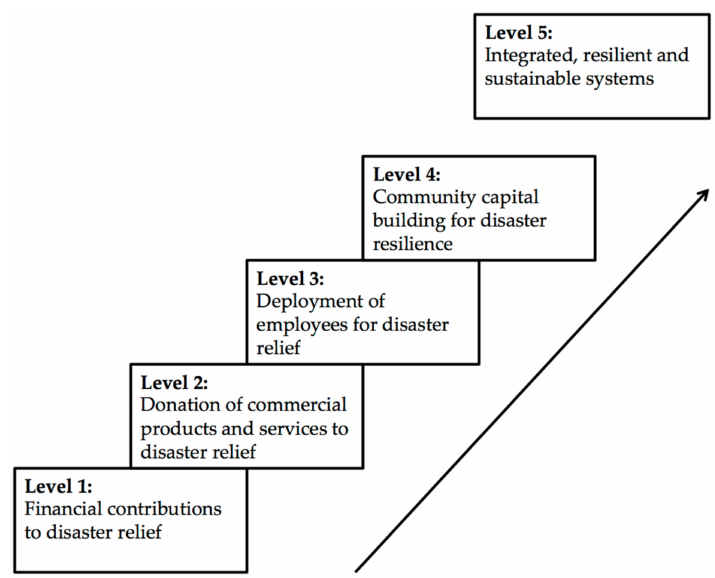
Figure 2. Five-level indicator framework to assess the disaster relief and resilience dimension of corporate social responsibility (CSR) management